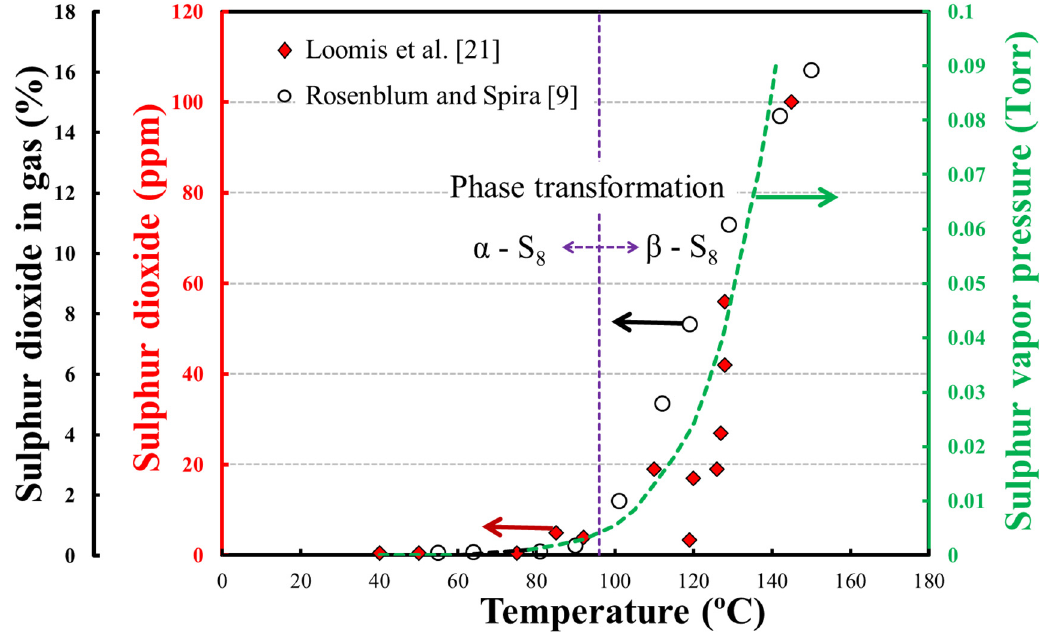
Figure 4. Compilation of literature data as a function of temperature: emission of SO 2 from lab test [9] and mine site [21]; sulphur vapour pressure; phase transition.